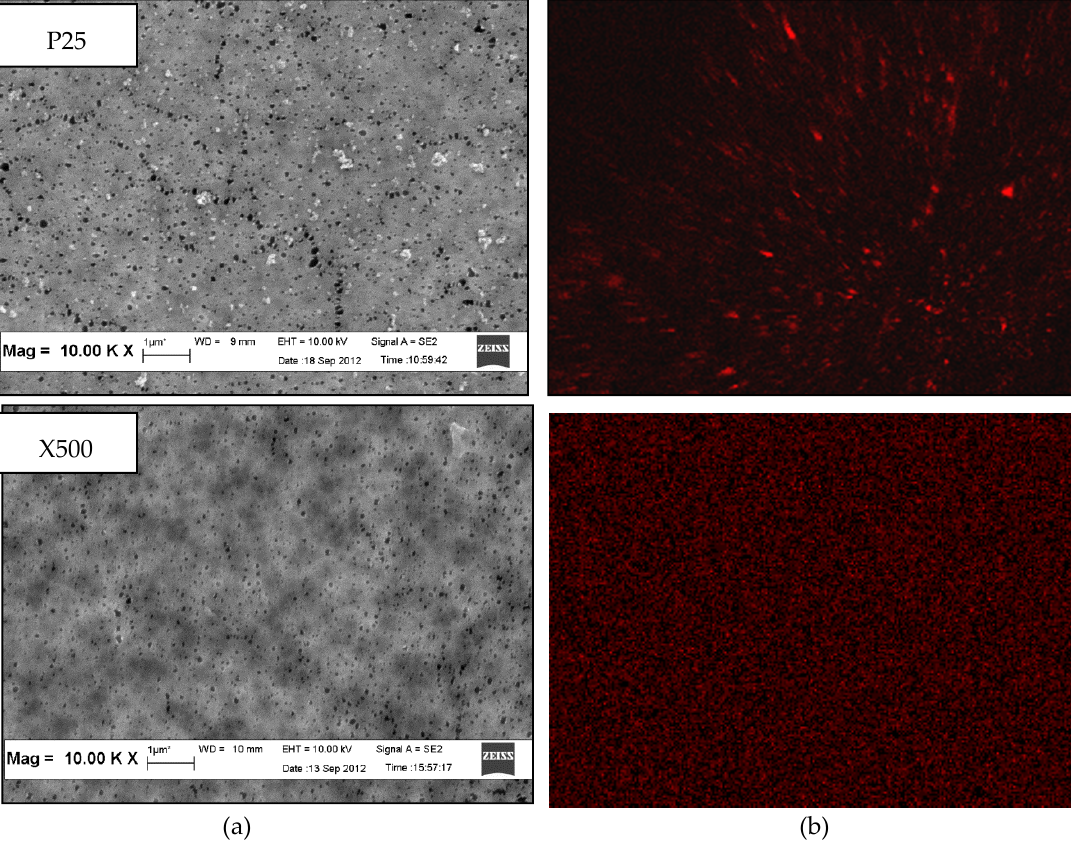
Figure 2. Top surface ( a ) field emission scanning electron microscopy (FESEM) micrographs and ( b ) energy dispersive X-ray (EDX) mapping of PVDF/TiO 2 mixed-matrix membranes (MMMs) incorporated with different types of TiO 2 (coagulation bath concentration = 0.01 g/L, pH = 4, ambient conditions).